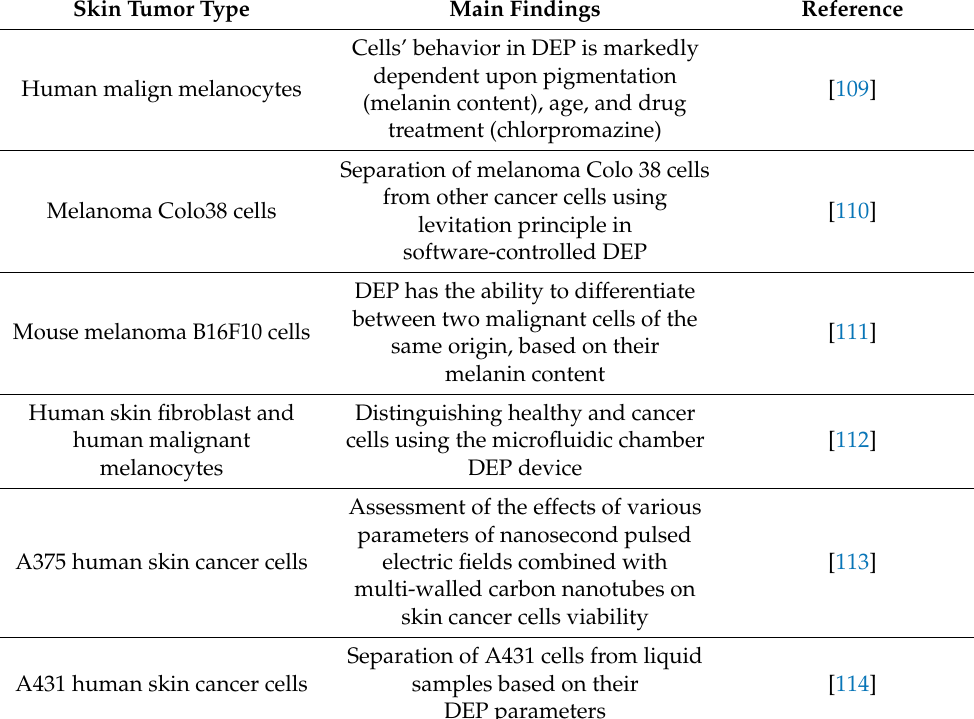
Table 4. Clinical studies of DEP in skin